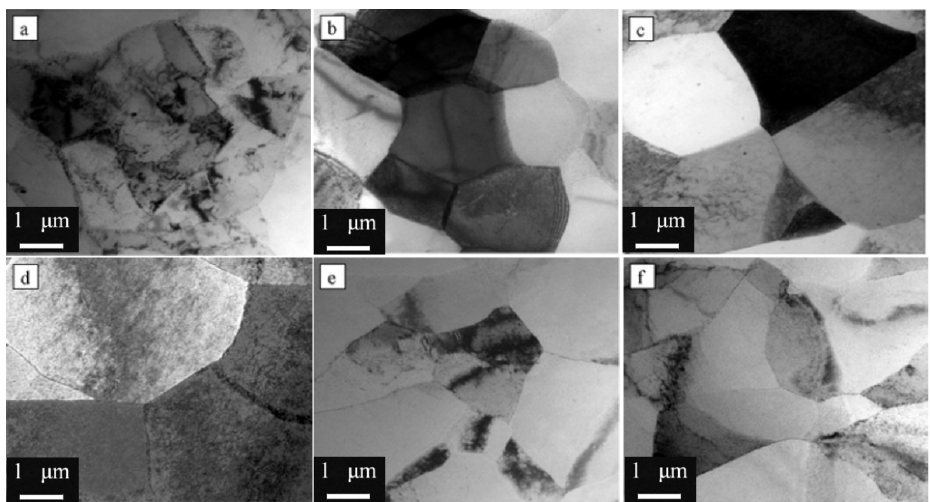
Figure 15. TEM micrographs of sub-grains of 7050 aluminum alloys under different heat treatment conditions: ( a ) SST440, ( b ) SST460, ( c ) SST470, ( d ) SST490, ( e ) EST and ( f ) HTPT [6].